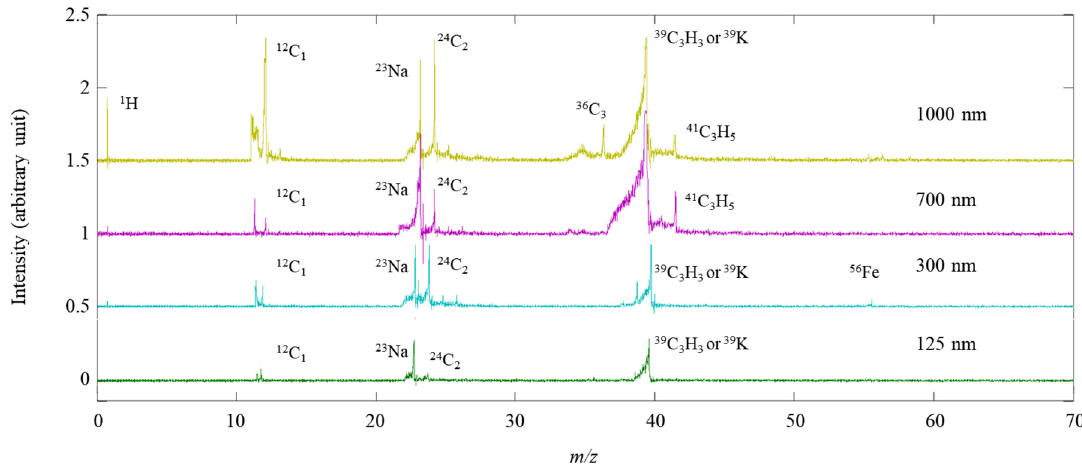
Figure 3. Single-particle mass spectra of PSL particles with different sizes (125 nm, 300 nm, 700 nm, and 1000 nm).